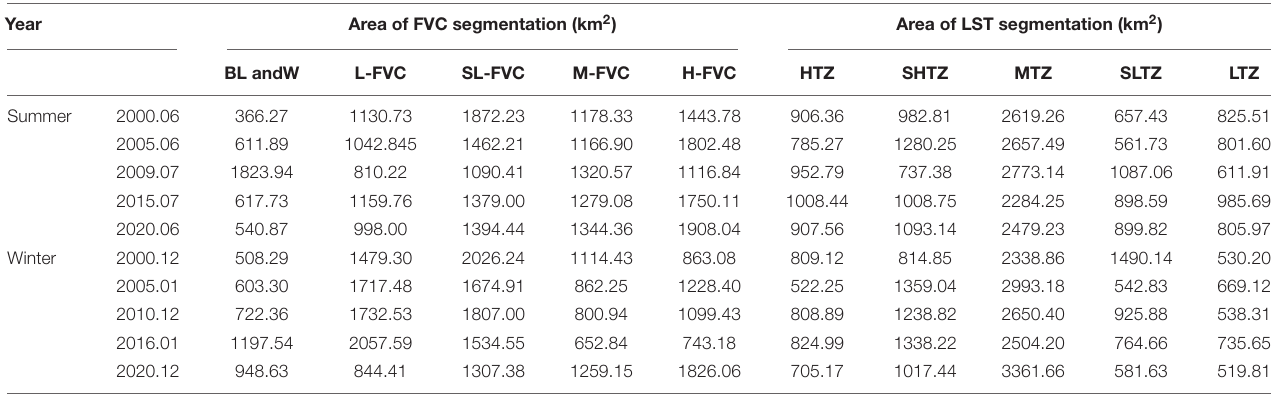
TABLE 2 | Area of fractional vegetation cover and land surface temperature segmentation. Year